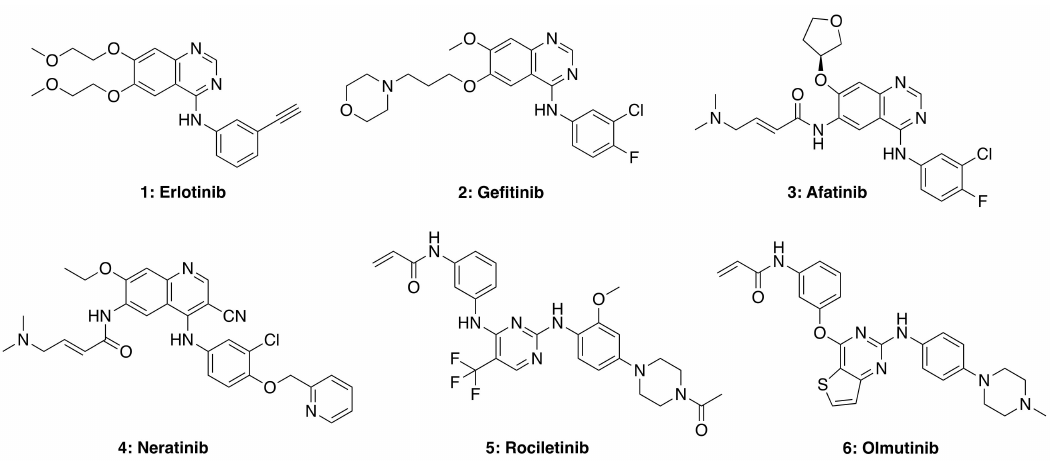
Figure 4. Representative structures of first ( 1 and 2 ), second ( 3 and 4 ), third ( 5 ), and fourth ( 6 ) generation EGFR TKIs. Structures were generated using Chemdraw based on structures of TKIs available in